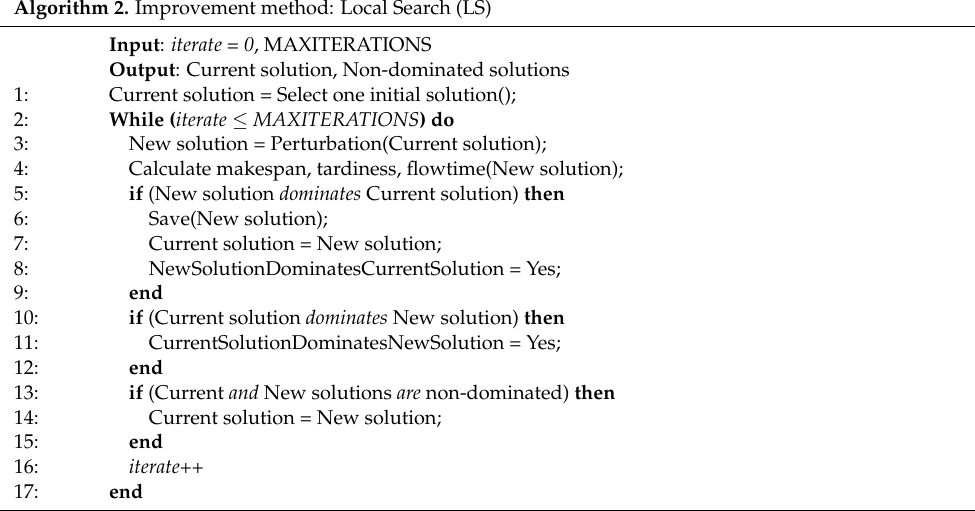
Algorithm 2. Improvement method: Local Search (LS)